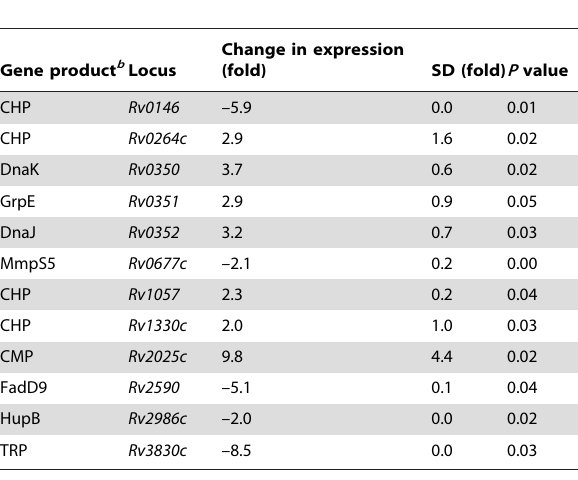
Table 1. Differentially expressed genes in Mtb treated with db-cAMP relative to butyric acid treated